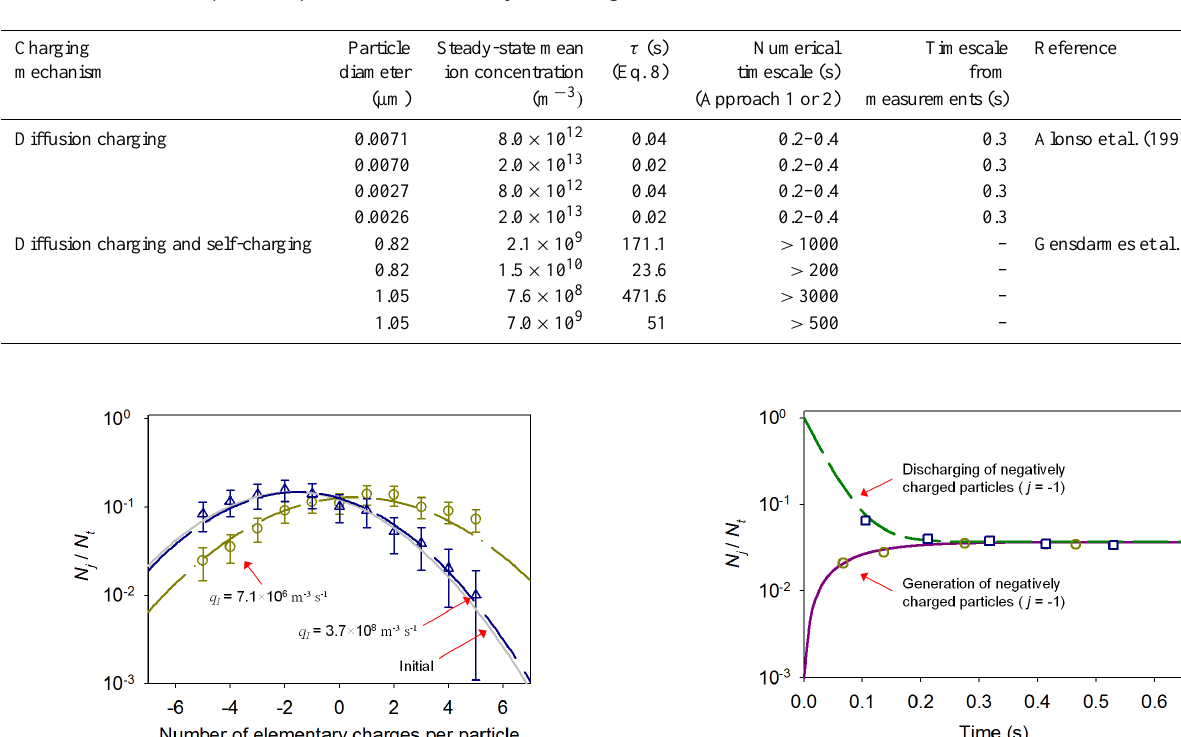
Table 2. Timescales required for particles to reach steady-state charge.